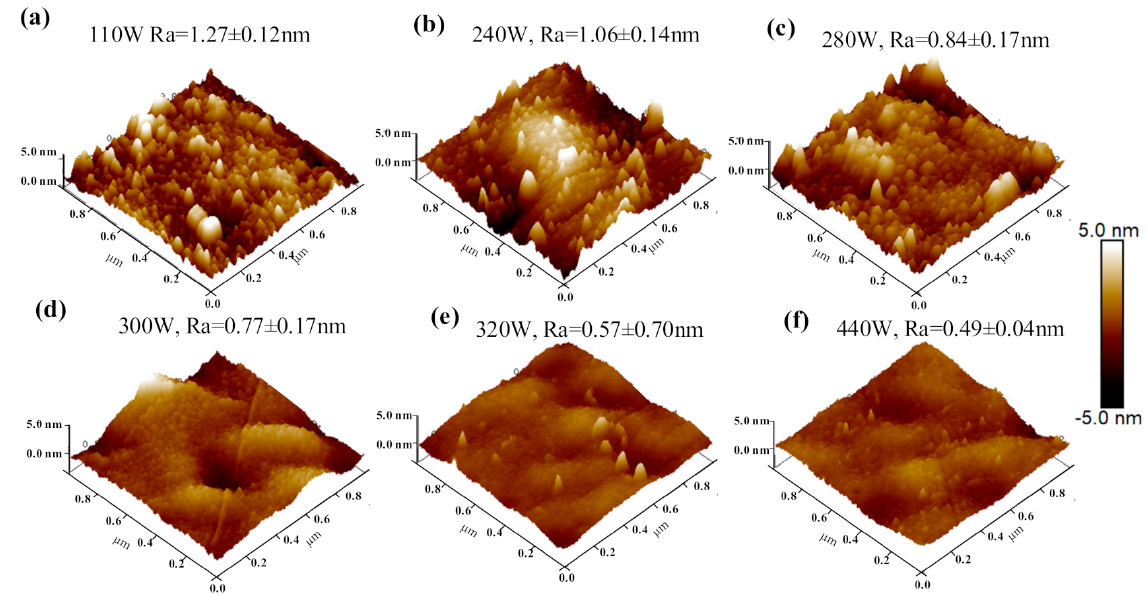
Figure 8. Atomic force microscopy (AFM) images of the Cr 2 AlC coatings deposited by HiPIMS at different average power: ( a ) 110 W, ( b ) 240 W, ( c ) 280 W, ( d ) 300 W, ( e ) 320 W, and ( f ) 440